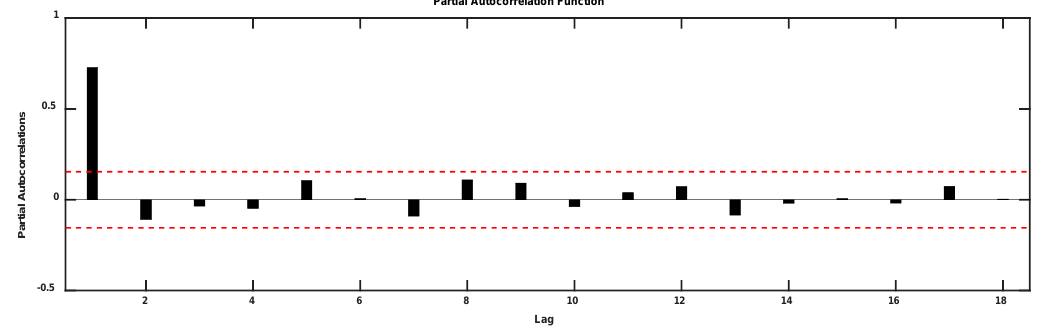
Figure 8. The partial autocorrelation function (PACF) of the groundwater level series at site M1255.